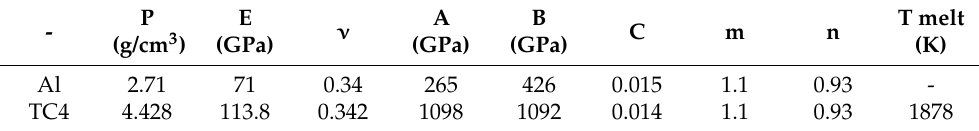
Table 3. Material parameters of TC4 and Al layers